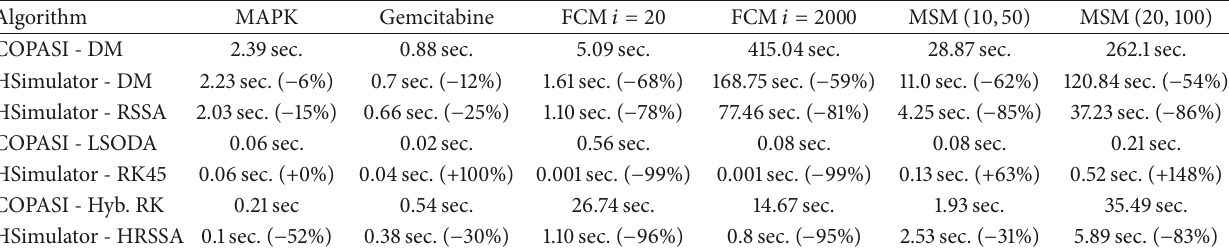
Table 2: Simulation running times of HSimulator and of the state-of-the-art simulator COPASI. Except for the deterministic simulation, HSimulator is demonstrated to be faster in all the considered scenarios (FCM indicates the fully connected model; MSM indicates the multiscaled model). The considered models were simulated for 150 time units (MAPK and fully connected model), 12 time units (Gemcitabine), and 10 time units (multiscaled